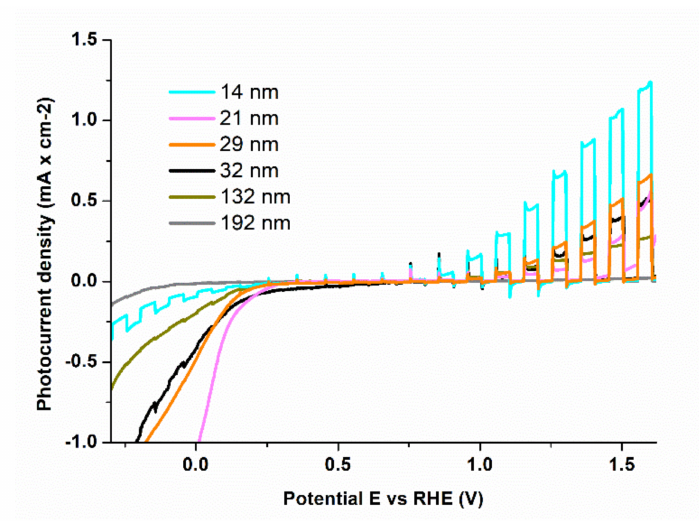
Figure 5. Potentiodynamic measurements under chopped irradiation on LFO/STON thin films with different thickness values in alkaline 0.5 M NaOH